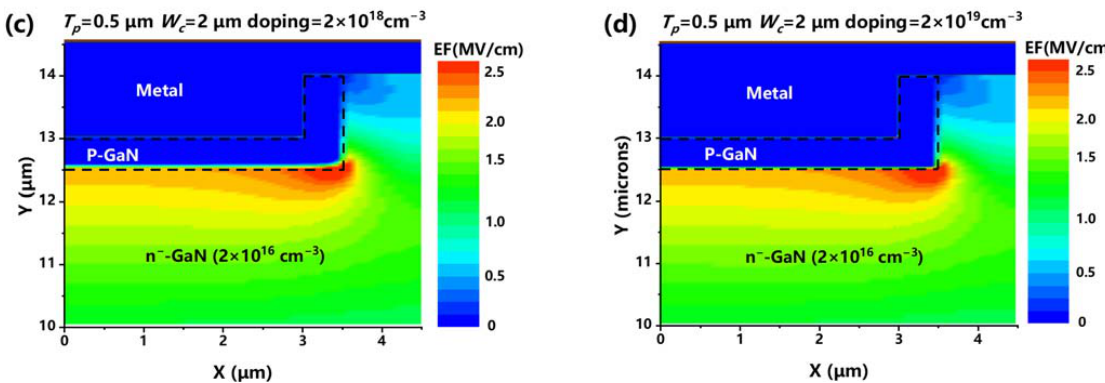
Figure 4. Local 2-D electric field distributions of TJBS diodes with p-doping concentrations of ( a ) 2 × 10 16 cm − 3 ; ( b ) 2 × 10 17 cm − 3 ; ( c ) 2 × 10 18 cm − 3 ; and ( d ) 2 × 10 19 cm − 3 at 600 V reverse biased and a drift layer concentration of 2 × 10 16 cm − 3 .